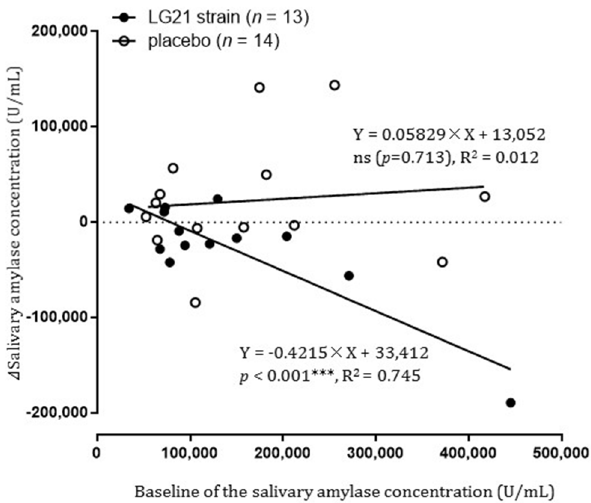
Figure 5. Relationship between salivary amylase concentration at baseline and ∆ salivary amylase concentration after 12 weeks of intake (PP population). A scatter plot was created, with salivary amylase concentration before intake on the x -axis and ∆ salivary amylase concentration after 12 weeks of intake on the y -axis, showing regression lines and regression equations for each test food group (significance level, p < 0.05 [two-sided]; *** p < 0.001 [two-sided]). R 2 , coefficient of determination; ns, not